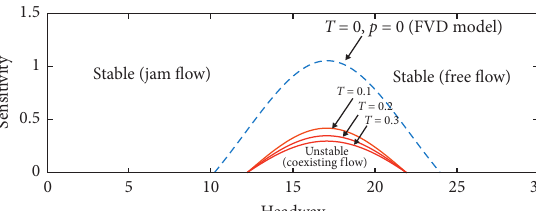
Figure 2: Phase diagram space of the AAFVD model in the parameter space ( Δ x,a ) according to various amounts of parameter ( T ) in p �